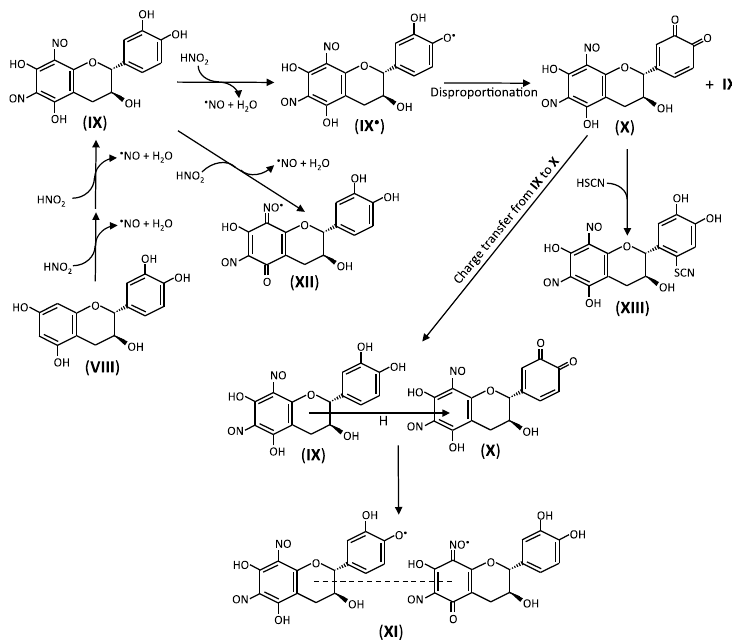
Figure 3. Postulated mechanism of the formation of charge-transfer complex and SCN-catechin conjugate [61,67]. ( VIII ) (+)-catechin, ( IX ) 6,8-dinitrosocatechin, ( IX • ) phenoxyl radical of IX , ( X ) quinone of IX , ( XI ) charge transfer complex formed from IX and X , ( XII ) nitrosyl radical of IX , ( XIII ) thiocyanate conjugate of X . ( − )-Epicatechin also reacts with nitrous acid as